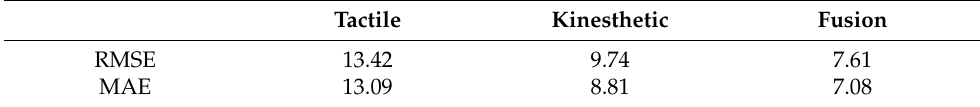
Table 3. RMSE and MAE% error of the entire test for each neural